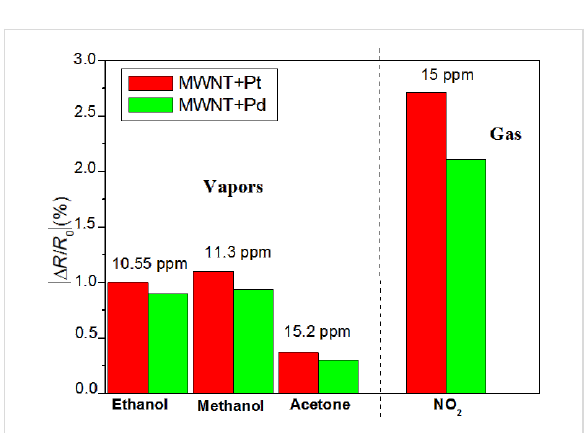
Figure 8: Comparison between the response of Pd–MWCNTs and Pt–MWCNTs to the different gases and vapours tested.